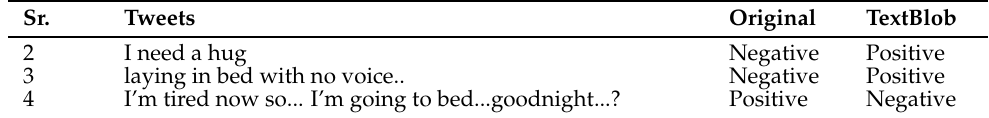
Table 5. Sample of tweets with corresponding original sentiments and sentiments extracted by